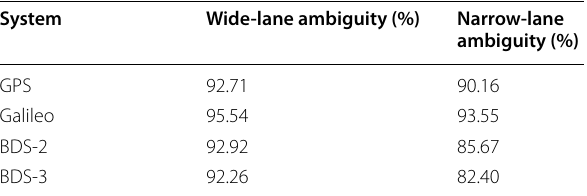
Table 4 Mean fixing rates of PPP-AR results